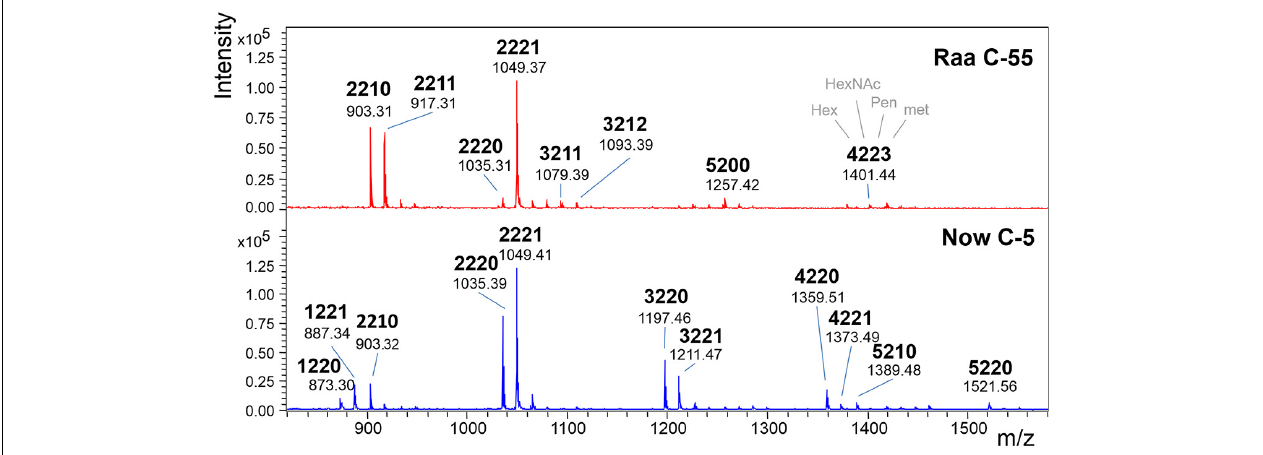
FIGURE 1 | MALDI-TOF MS spectra of “Raa” and “Now” type total N -glycans. The 4-digit code interprets the [M+Na] + ions in terms of numbers of hexoses, N -acetylhexosamines, pentoses, and methyl groups. Complementary mass spectra are deposited in Supplementary Figure 1